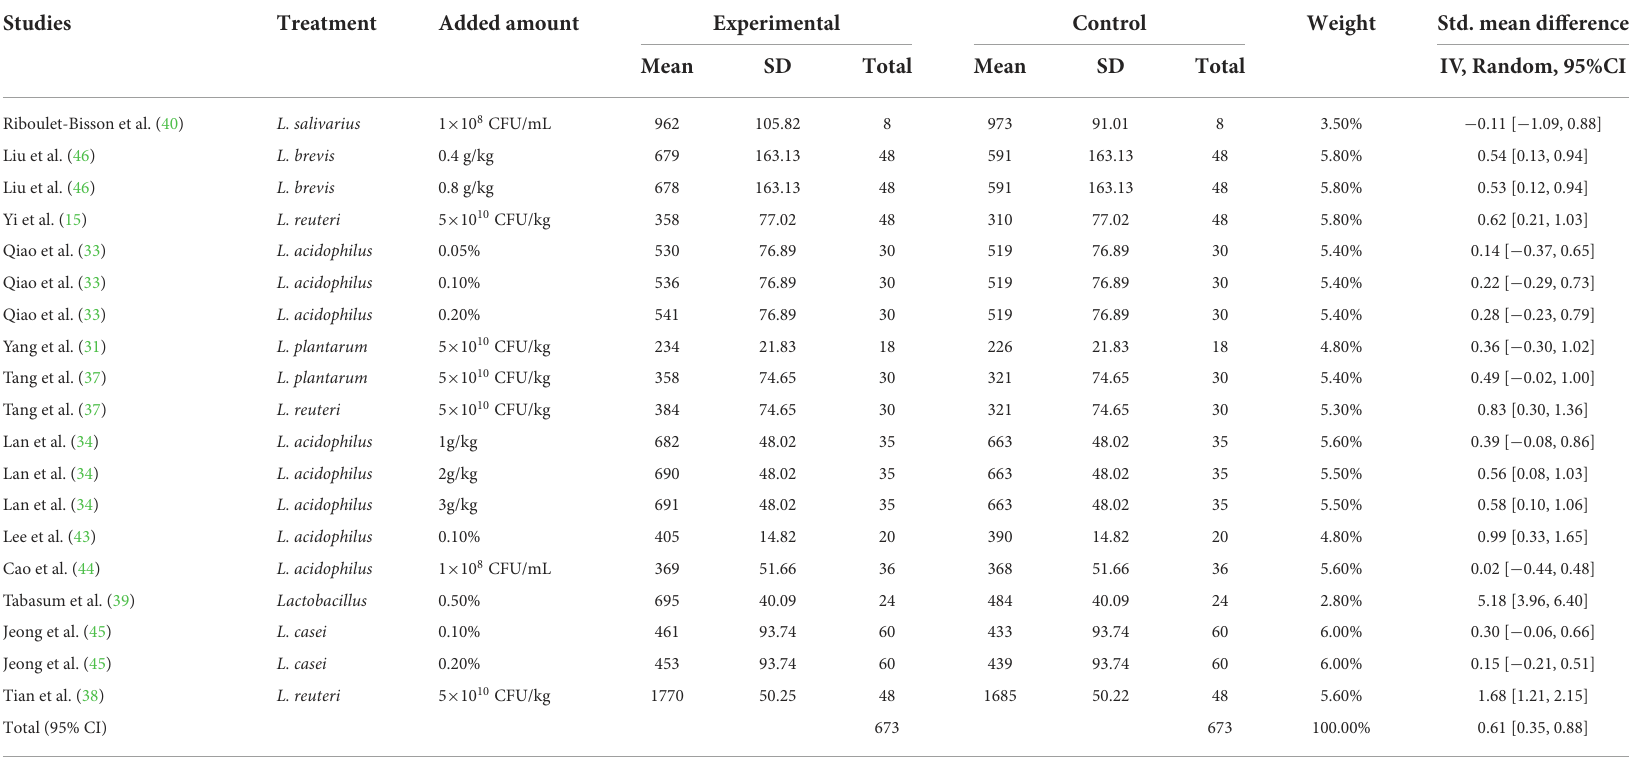
TABLE 3 Effects of Lactobacillus –based probiotics on the average daily feed intake (ADFI) pigs from included